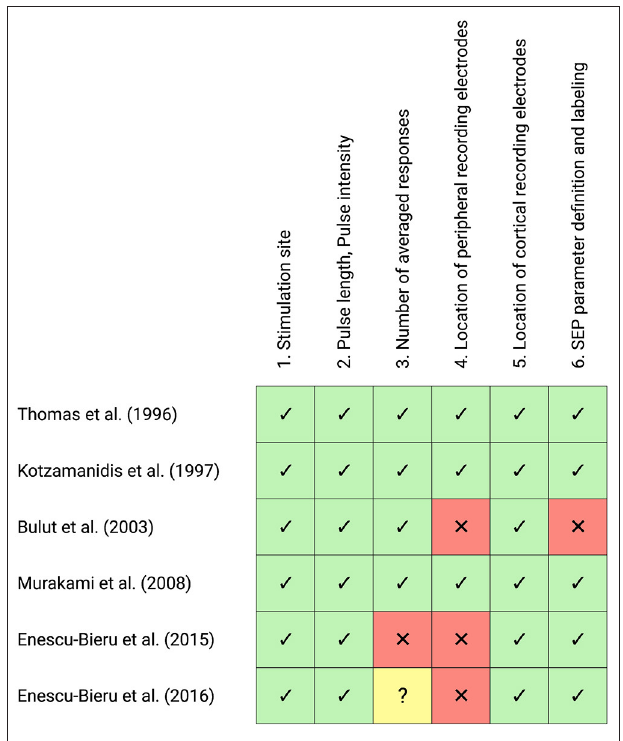
FIGURE 3 | Evaluation of Somatosensory-evoked potential (SEP) methodology of all included studies investigating short-latency SEP according to IFCN guidelines. The checklist consists of seven items regarding the methodological recommendations of SEP measurements, with the following choices: agreement (green cells with ticks), violation (red cells with crosses), unclear (yellow cells with question marks). This figure was created with